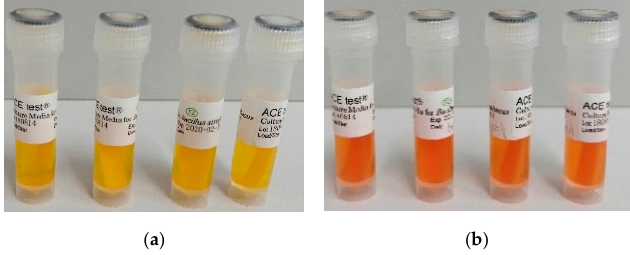
Figure 10. The indicator papers with B. atrophaeus spores (ATCC 9372) placed in culture media, after incubation. Positive result—microbial growth, (a). Negative result—no microbes, effective sterilization (b).